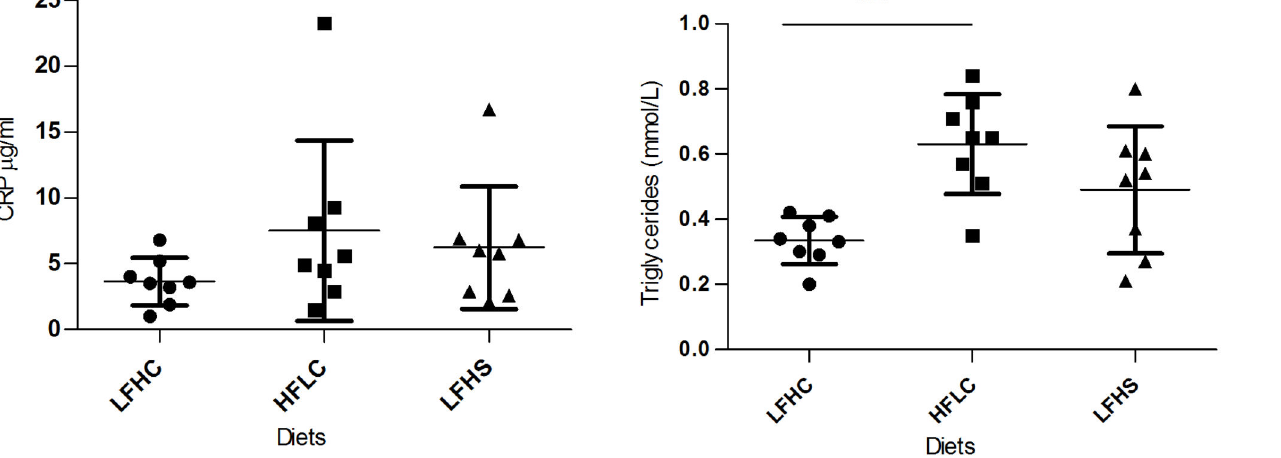
Figure 6. Triglycerides in minipig serum by the end of the study. Triglyceride concentrations (mmol/l) ±SD for minipigs fed low fat, high carbohydrate diet (LFHC); high fat/cholesterol, low carbohydrate diet (HFLC); low fat, high carbohydrate/ sucrose diet (LFHS). *** p < 0.001).